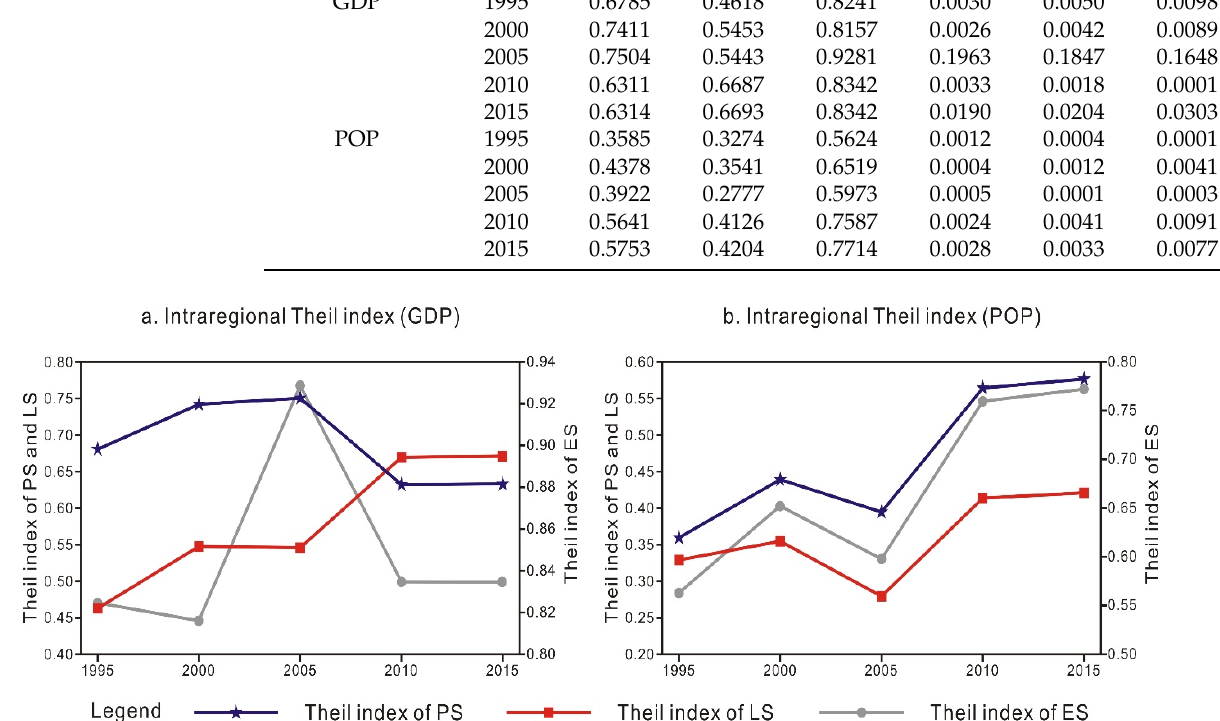
Figure 6. Change trend of the PLES-related Theil index in the region, 1995–2015. Note: The left ordinate indicates the PS and LS, and the right ordinate indicates the ES.